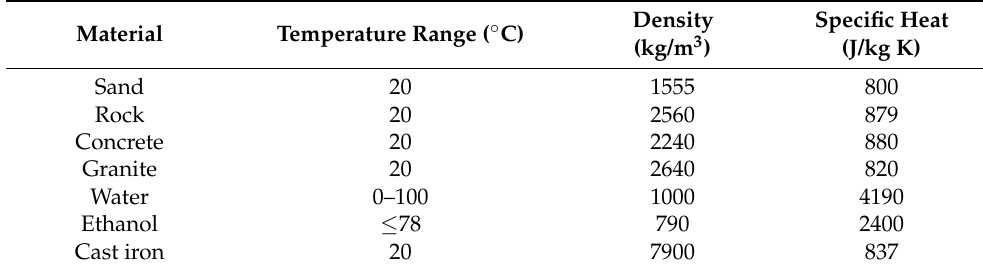
Table 3. Sensible heat storage materials [13].